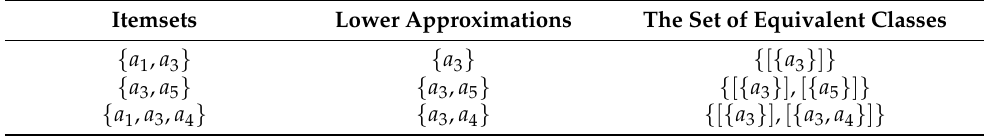
Table 7. Itemsets and their lower approximations of Example 2.